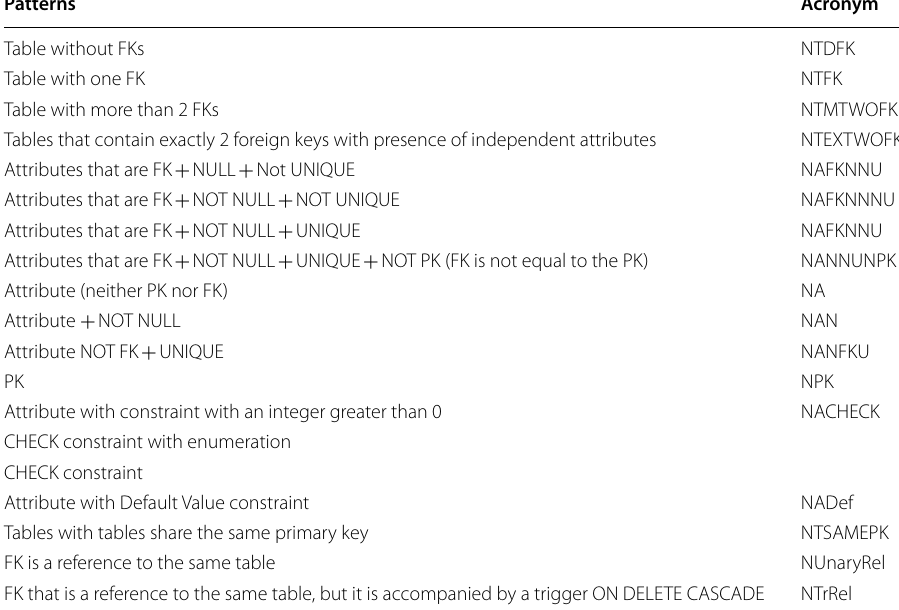
Table 1 Summary of patterns to calculate NS Patterns Acronym Table without FKs NTDFK Table with one FK NTFK Table with more than 2